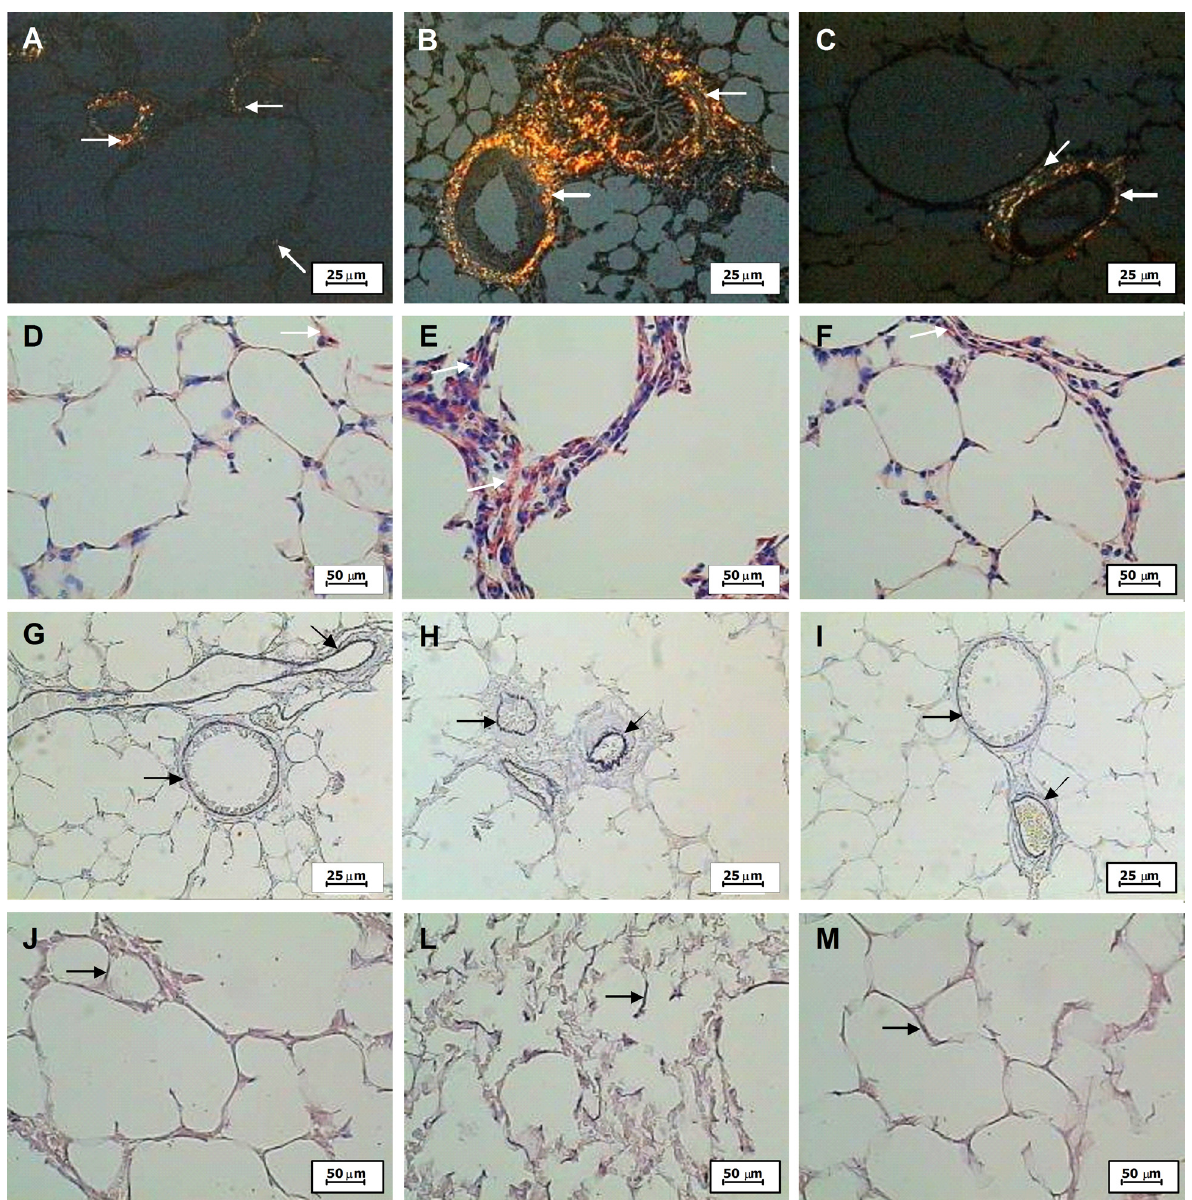
Figure 3. Lung remodeling. Non-cartilaginous airways, vessels and lung tissue obtained from saline-exposed (NS group = panels A, D, G, and J), ovalbumin-exposed (OVA group = panels B, E, H, and L), and ovalbumin-exposed and capsaicin-pretreated guinea pigs (CAP-OVA group = panels C, F, I, and M) were stained with Picrosirius and observed under polarized light (A-C) or not (D-F) or stained with Resorcin-Fuchsin (G-M). Saline-exposed animals showed a weak yellow-greenish birefringence along the walls in the tissue section (A and D), coinciding with the maintenance of the histoarchitecture of the extracellular matrix and scant elastic fibers (G and J). In contrast, tissue sections from the OVA group show an intense constriction and an increase in collagen and elastic fiber content in airways and vessel walls (B and H) as well as in lung tissue (E and L). Capsaicin pretreatment attenuated collagen (C and F) and elastic fiber deposition (I and M) in the airways, vessels (C and I) and lung tissue (F and